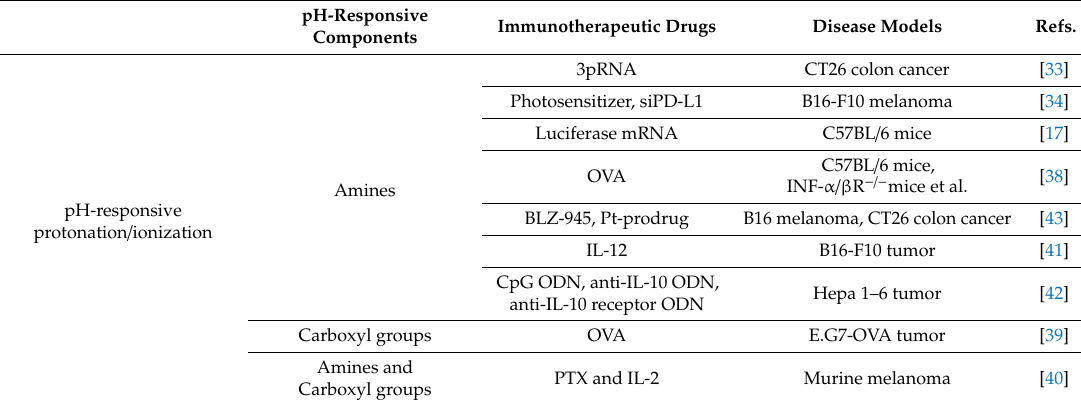
Table 1. Selected pH-responsive nanoparticle systems for cancer